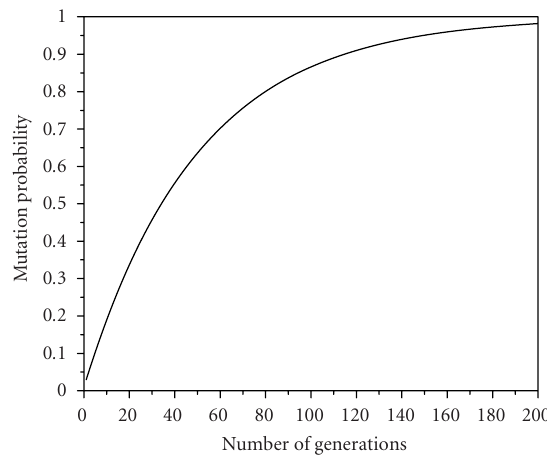
Figure 2: Mutation probability with the generation.